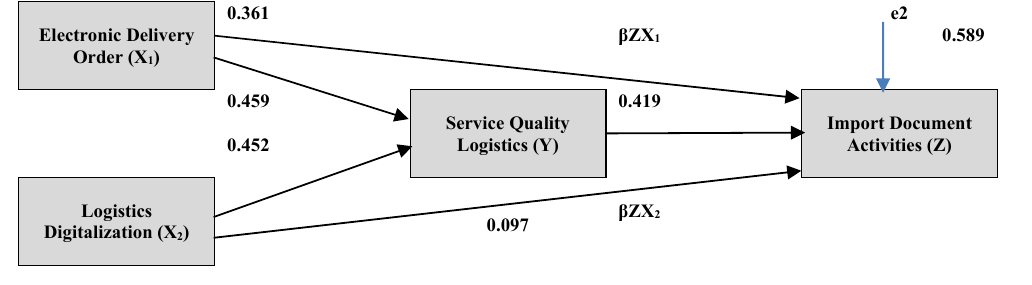
Fig. 3. Sub-Structural Correlation of X 1 , X 2 , to Y Result of the Test of Determination Coefficient of Sub-Structural II Model